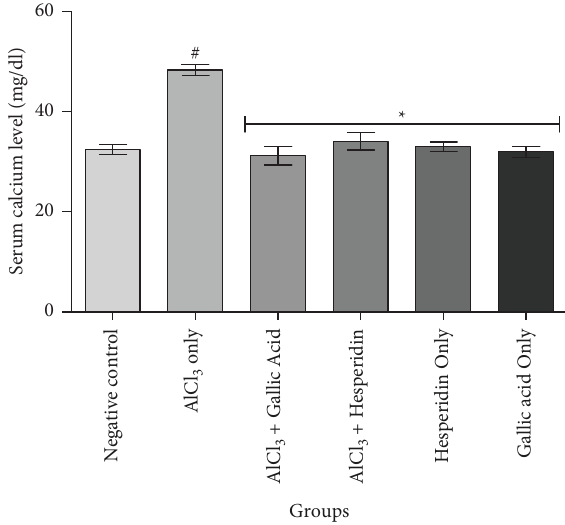
Figure 2: Effect of gallic acid and hesperidin on renal Ca 2+ /Mg 2+ ATPase activity in AlCl 3 -induced nephrotoxicity in Wistar rats. Values are expressed as mean ± standard deviation of six deter- minations. # p < 0 . 05 vs negative control, ∗ p < 0 . 05 vs. AlCl 3 only.